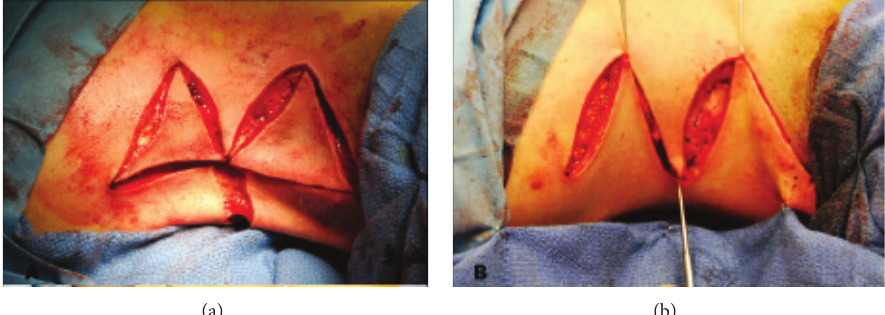
Figure 5: (a) Initial incisions made with hair-bearing skin to be removed within the superior intervening triangle; (b) completed zig-zag closure.